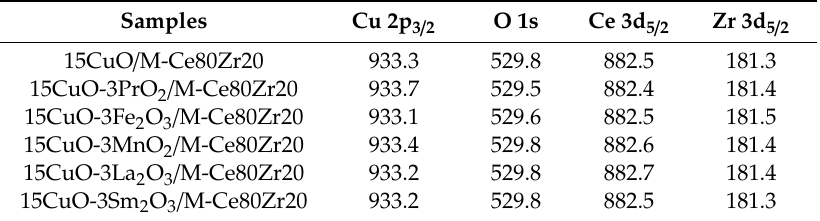
Table 2. Binding energies (eV) of the surface elements of the catalysts.